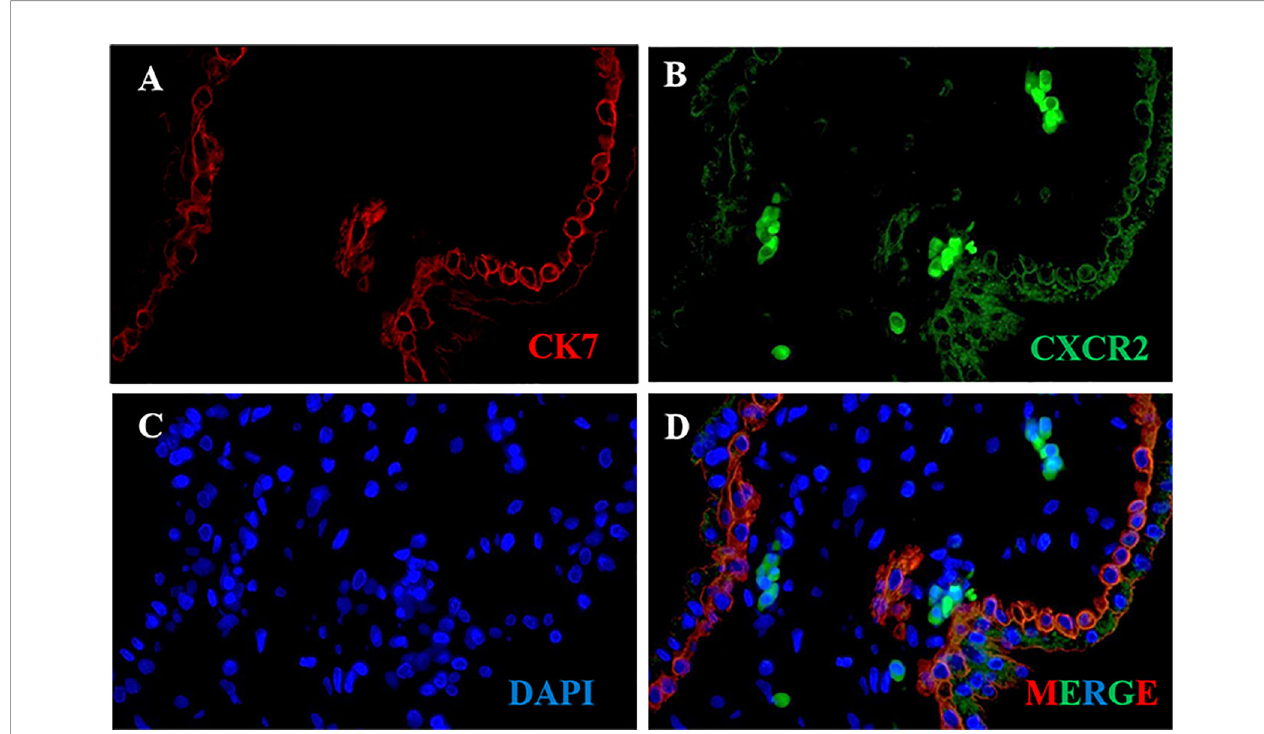
FIGURE 2 | CXCR2 expression in trophoblast of human placental villous tissues. Paraf fi n-embedded tissue sections were double-stained for immuno fl uorescence. (A) The CK7-labeled trophoblast cells are indicated by red signals. (B) The CXCR2 protein is indicated by green signals. (C) The DAPI-stained nuclei are indicated by blue signals. (D) CXCR2 was expressed in CK7-labeled trophoblast cells and strongly indicated the colocalization of CK7 and CXCR2. CK7, cytokeratin 7; CXCR2, C-X-C motif chemokine receptor 2; DAPI, 4 ′